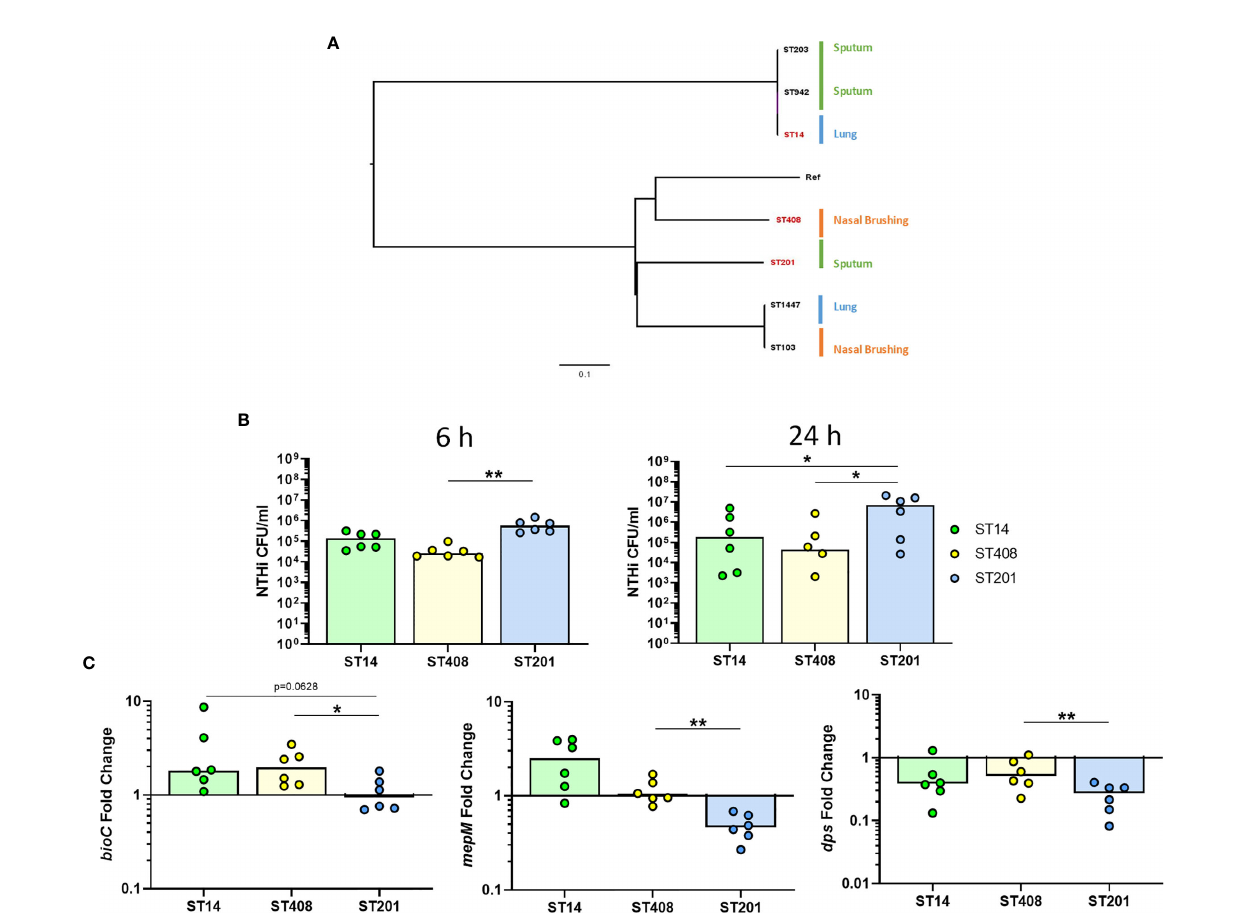
FIGURE 8 | Strain-dependent differences during NTHi persistence. (A) The diversity of seven clinical NTHi isolates were assessed by ParSNP using default parameters and NTHi 86-028NP as the reference strain. Strains were isolated from either from sputum sample (green), nasal brushing (orange) or protected bronchial brushes of the lung (blue). Phylogenetic tree was created in FigTree using ParSNP output fi les and strains highlighted in red (ST14, ST408 and ST201) indicate the strains chosen for further in vitro experimental analysis. (B) Invasion and persistence within MDM by the three chosen different strains of NTHi was measured by live viable counting at the 6 h and 24 h time points. (C) Expression of the top regulated NTHi genes were differentially expressed by additional clinical strains of NTHi during intracellular persistence. Gene expression was normalised to NTHi rho gene and data are shown as fold change in expression from 6 h to 24 h Graphs show paired data and lines indicate medians. N = 6. Data were analysed using Friedman test with Dunn ’ s multiple comparisons; *p < 0.05, **p <